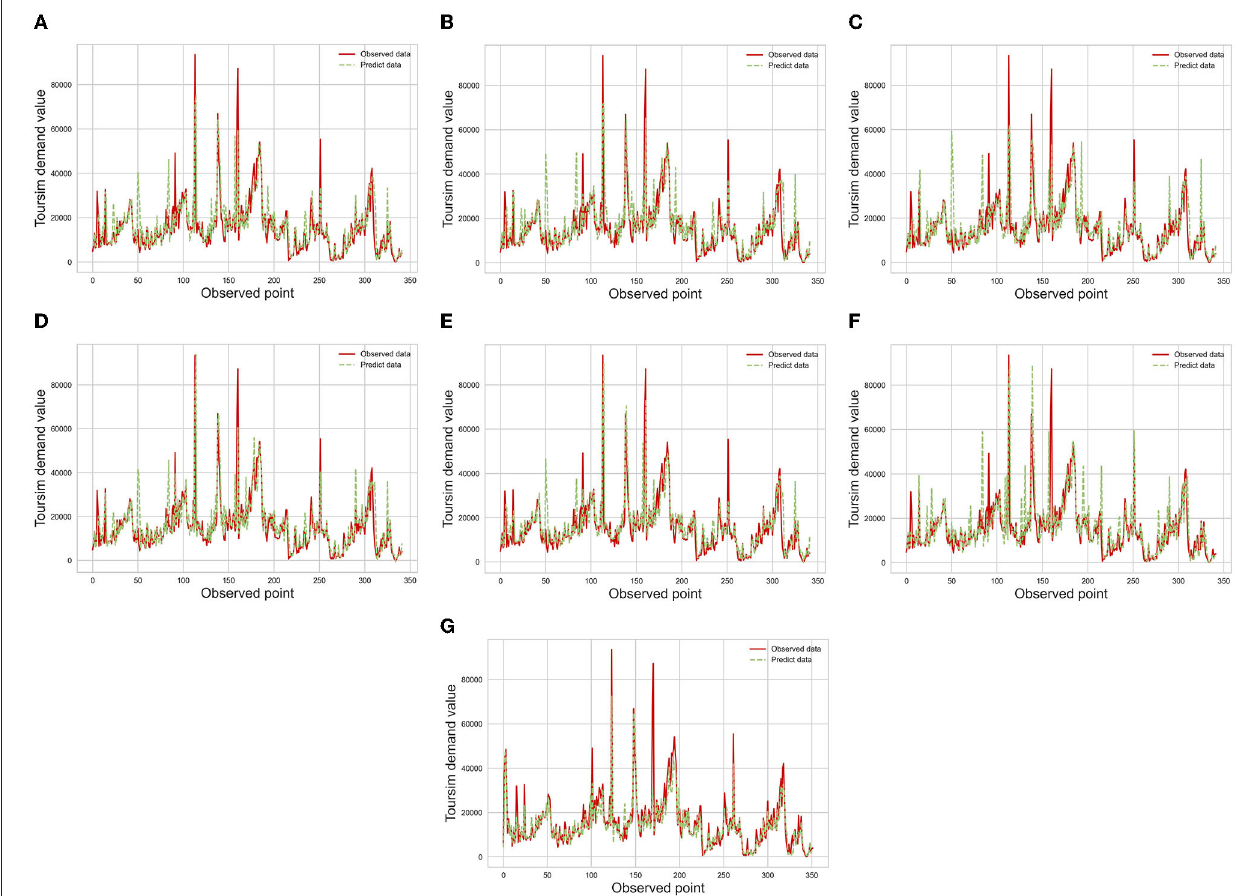
FIGURE 4 | The overview of the forecasting results in different model. (A) Forecasting results of RF, (B) forecasting results of ET, (C) forecasting results of LGB, (D) forecasting results of XGBoost, (E) forecasting results of GB, (F) forecasting results of DT, (G) forecasting results of Ours.